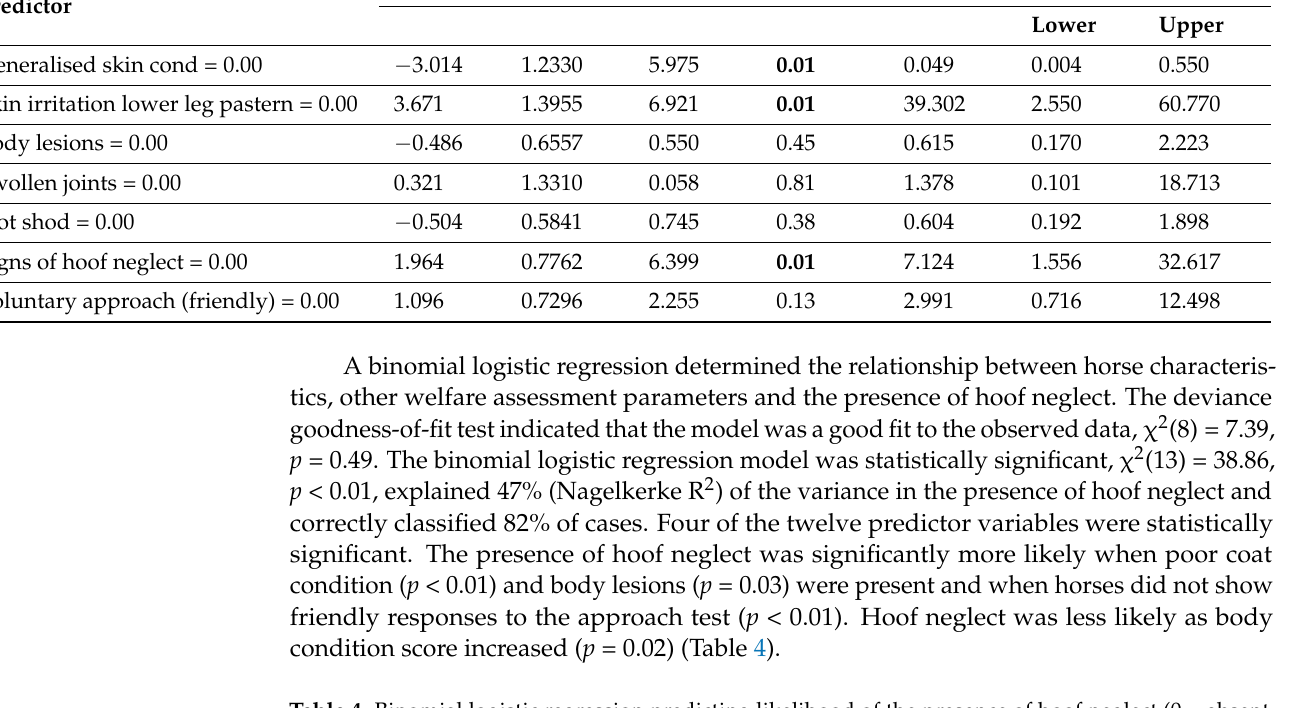
Table 4. Binomial logistic regression predicting likelihood of the presence of hoof neglect (0 =